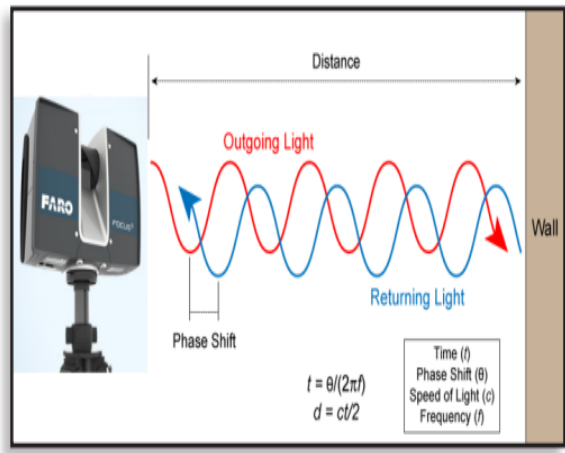
Figure 5(a). The working principle of Phase-based measurement.